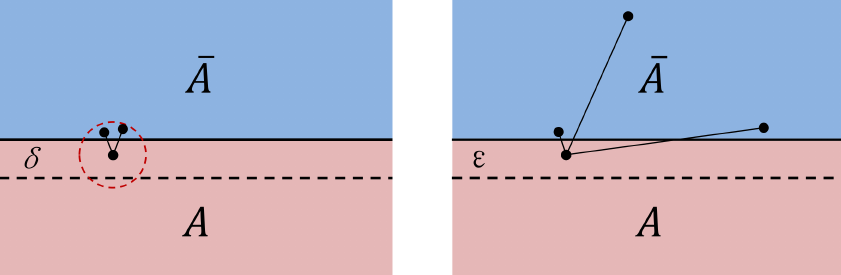
Figure 1: The δ neighborhood of a point P consists of all the points whose distance from P is smaller than δ (see the region inside the dashed red circle). In the left figure, the UV regulator excludes the correlation between P and those inside the overlap between its δ neighborhood and ¯ A . While in the right figure, the geometric regulator exclude the correlation between P (in certain cutoff region) and all the degrees of freedom inside ¯